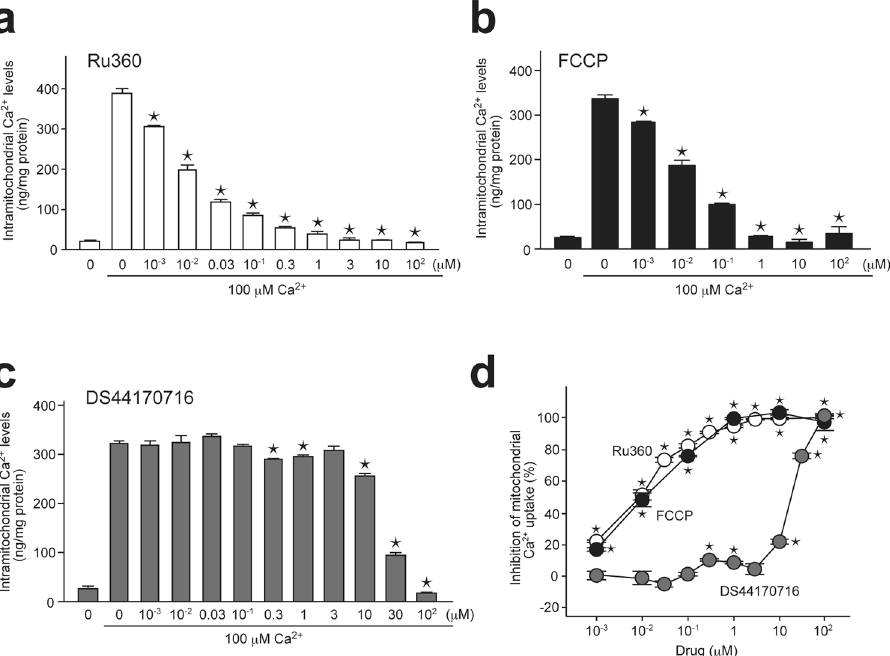
Figure 3. DS44170716 inhibits mitochondrial Ca 2 + uptake in isolated mitochondria from pig heart. ( a ) Effect of Ru360 on Ca 2 + uptake activities of isolated mitochondria. ( b ) Effect of FCCP on Ca 2 + uptake activities of isolated mitochondria. ( c ) Effect of DS44170716 on Ca 2 + uptake activities of isolated mitochondria. ( d ) Inhibitory effects of drugs on Ca 2 + uptake activities of isolated mitochondria. Inhibition 100 or 0% was defined as the mean of vehicle-treated samples or 100 μ M CaCl 2 -treated samples, respectively. Data obtained from 3 independent samples are shown as the mean with SEM. Asterisk shows P < 0.05 compared to vehicle group (Dunnett’s